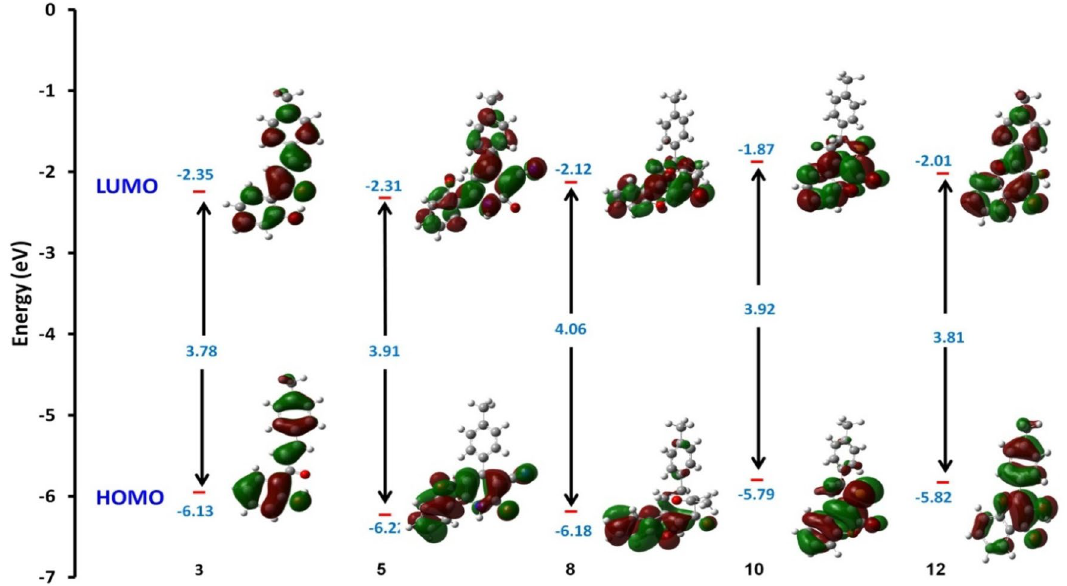
Figure 11. Schematic diagrams of HOMO and LUMO energy levels of compounds 3 , 5 , 8 , 10 and 12 obtained from the DFT calculation with